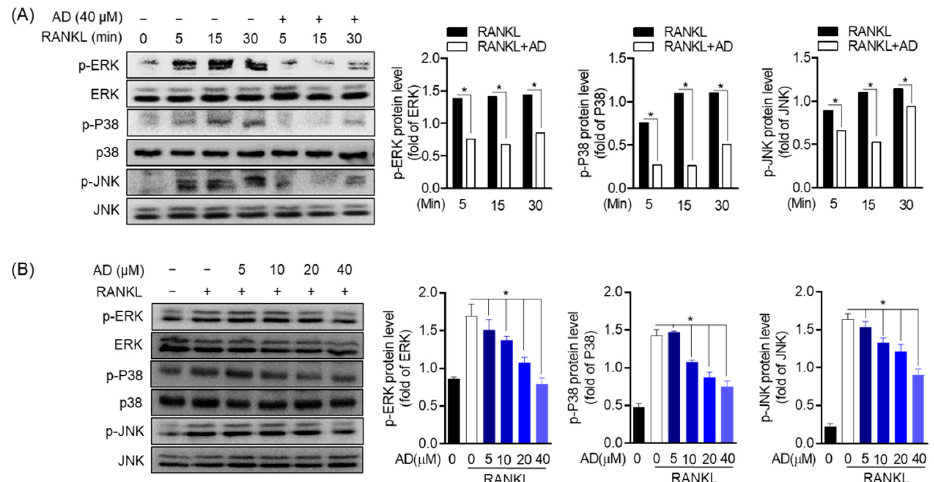
Figure 8. AD decreases the expression of RANKL-induced MAPKs activation. RAW 264.7 cells (5 × 10 5 cell/mL) were seeded in 6-well plate and incubated for 24 h. ( A ) Cells were pre-incubated with AD (40 µM) for 2 h before treating with or without RANKL (50 ng/mL) for 5, 15, and 30 min. ( B ) Cells were treated in the presence or absence of AD at the indicated concentration, then stimulated with or without RANKL (50 ng/mL). Then, cell lysates were subjected to Western blot analyses to detect the activation of MAPK. * p < 0.05 versus the RANKL-treated group.